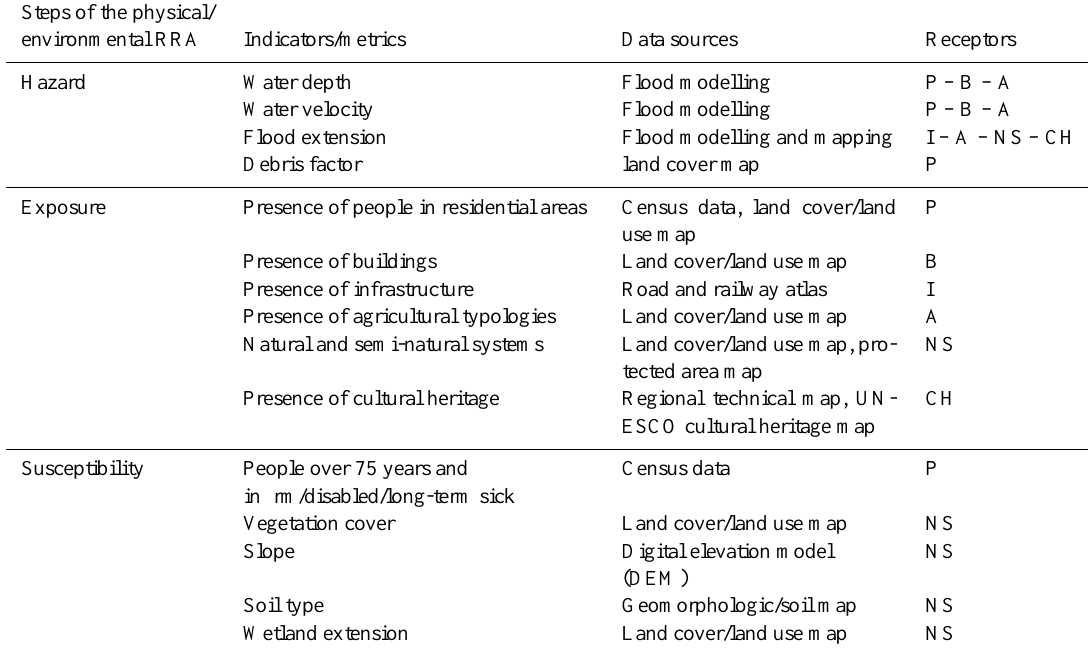
Table 7. Characterization of data used for the three phases of assessment, according to the physical/environmental KR-RRA approach, for the selected receptors (P: people; B: buildings; I: infrastructure; A: agriculture; NS: natural and semi-natural systems; CH: cultural